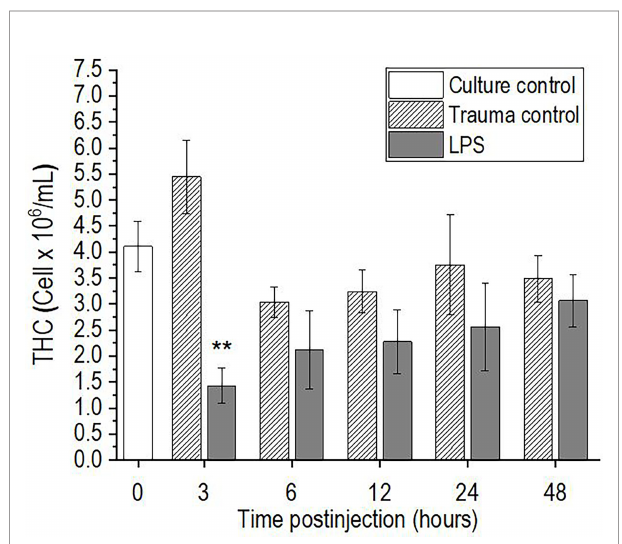
FIGURE 1 | Time-course of total hemocyte count (THC) for the hemolymph of P. scaber injected with 0.5 m L DPBS (trauma control)and lipopolysaccharide (LPS; 0.5 m g/ m L). Culture control represents P. scaber not subjected to any injection.Data are means ± SE. **p <0.01, versus trauma control (n=